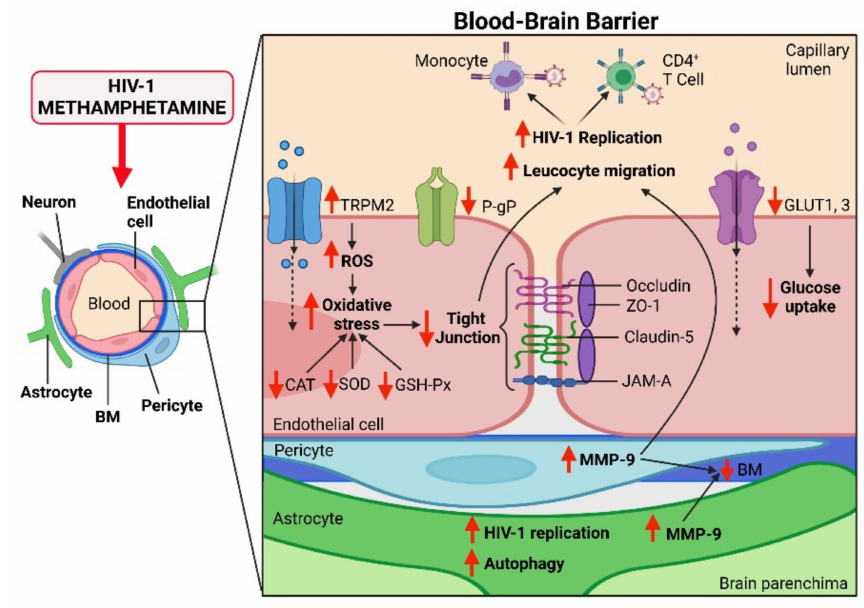
Figure 2. Synergistic impact of HIV-1 infection and methamphetamine (METH) use on the blood– brain barrier (BBB). The main component of the BBB is endothelial cells, which are bridged by tight junction (TJ) protein complexes. Illustrated are four critical TJ proteins that are synergistically affected by comorbid HIV-1 infection and METH: occludin, zonula occludens 1 (ZO-1), claudin-5, and junctional adhesion molecule-A (JAM-A). In addition, HIV-1 infection and METH synergistically affect carrier-mediated transport across the BBB by impairing the functions of P-glycoprotein (P-gp) and two glucose transport proteins, GLUT1 and GLUT3. METH and HIV-1 also synergistically induce oxidative stress via activation of transient receptor potential melastatin 2 (TRPM2) channels in endothelial cells. The combination of METH and HIV-1 infection induces excessive production of reactive oxygen species (ROS) and impairs the defensive abilities of antioxidant enzymes catalase (CAT), glutathione peroxidase (GSH-PX), and superoxide dismutase (SOD). Elevated activity of matrix metalloproteinase-9 (MMP-9) leads to the degradation of the basement membrane (BM). Increased BBB permeability due to degradation of TJs and BM proteins may facilitate transmigration of HIV-1-infected monocytes and CD4+ T cells into the brain. METH enhances HIV-1 replication in HIV-1 infected CD4+ T cells, likely stimulating transmigration of infected immune cells across the BBB. HIV-1 replication can be enhanced by METH, contributing to increased viral load in the brain. Created with